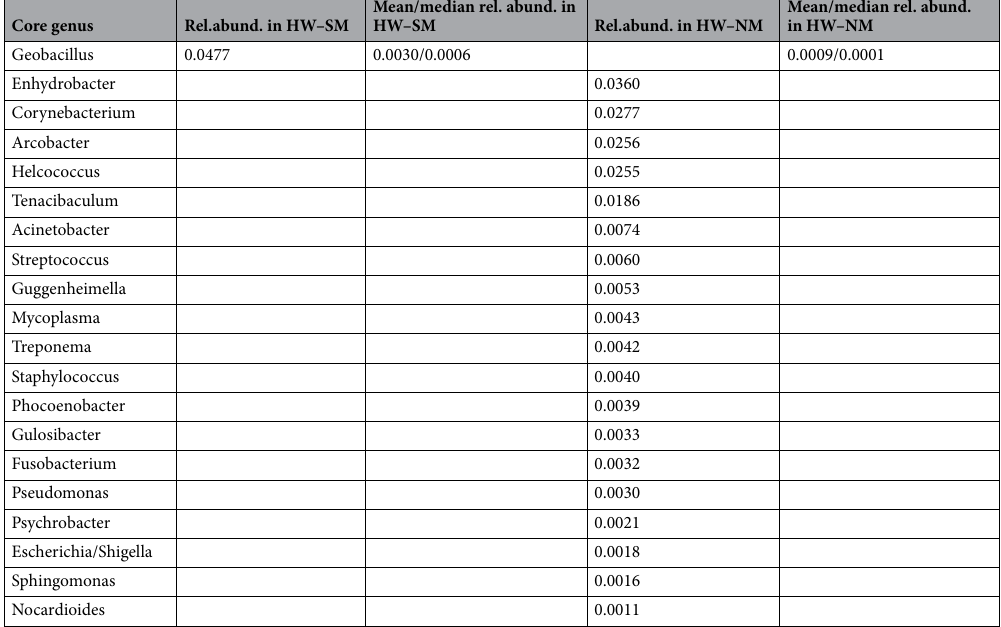
Table 4. Taxonomy and relative abundance of core genera of the blow of 20 humpback whales at the beginning of their fasting (HW–NM) and 20 humpback whales at a later stage (HW–SM) in descending order of the genera’s relative abundance. An 80% threshold (core taxa present in 80 of individuals in each group) was used. Whereas the HumpbackNM samples showed a large number of core genera, the HumpbackSM samples had only one.